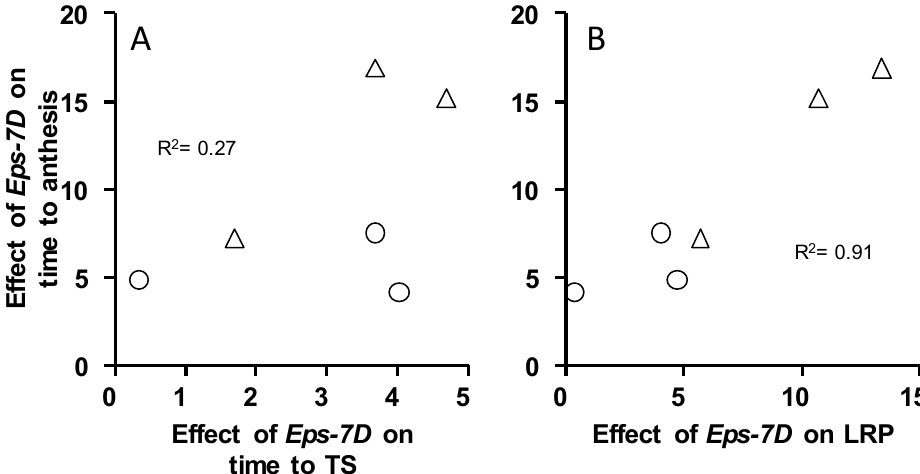
Figure 3. Relationships between the effects of Eps-7D (i.e., difference in duration between the lines with the late and early alleles) on time to anthesis and on its component phases: time from seedling emergence to terminal spikelet (TS, A ) and time from then to anthesis, i.e., the late reproductive phase (LRP, B ) for the lines carrying the insensitive (circles) and sensitive (triangles) Ppd-D1 alleles in the